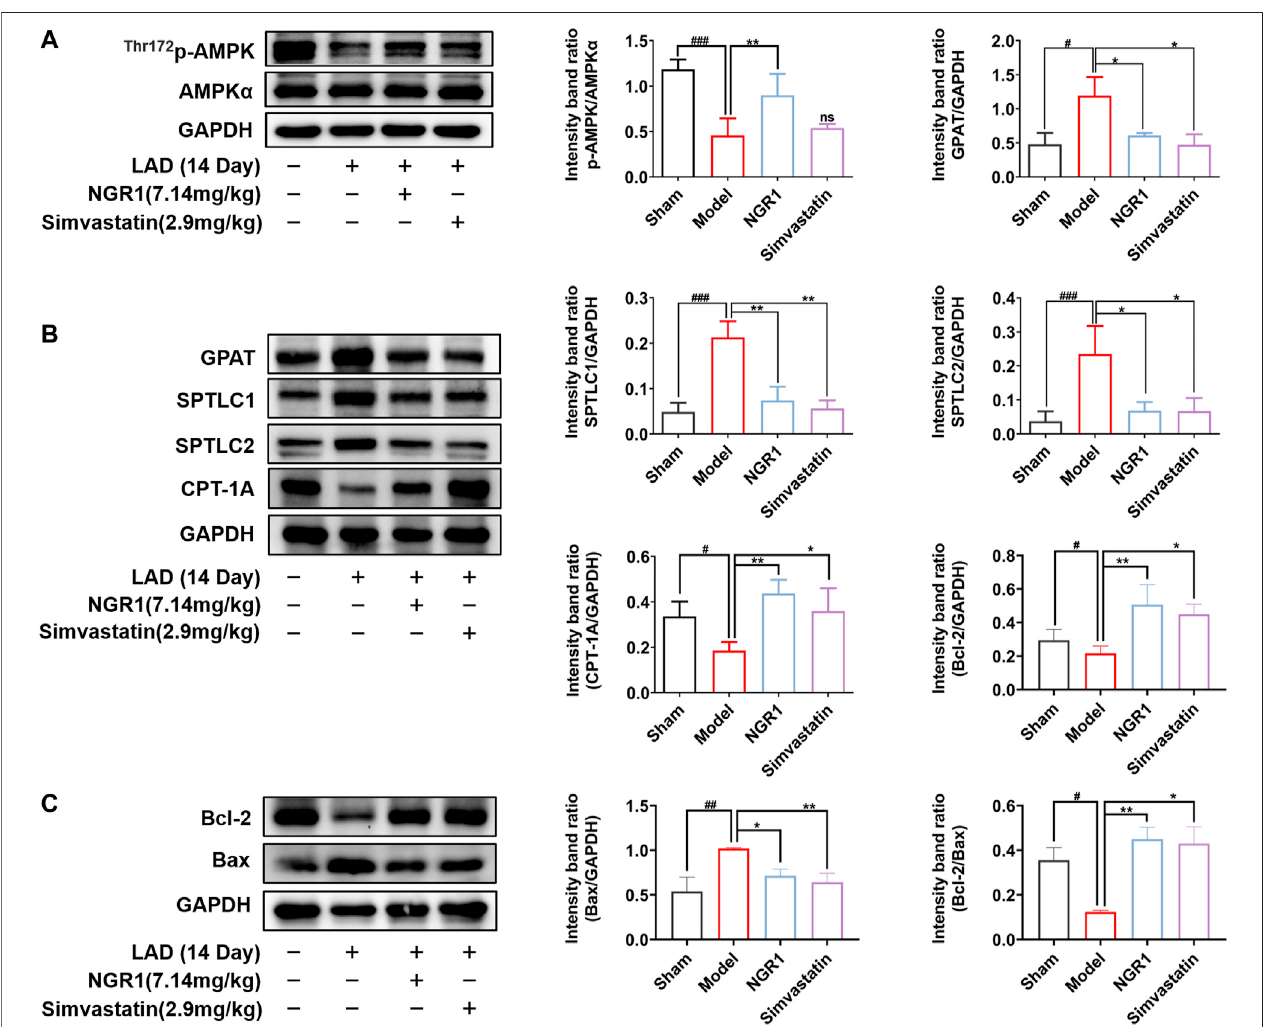
FIGURE 3 | NGR1 regulated lipotoxicity-related proteins and reduced apoptosis in the HF mice model. ( A-C) Western blot analysis of p-AMPK, AMPK, GPAT, SPTLC1, SPTLC2, CPT-1A, Bcl-2 and Bax in each group of mice. GAPDH served as the internal control, * p < 0.05, ** p < 0.01 vs. model group, # p < 0.05, ## p < 0.01, ### p < 0.001 vs. sham group, ns stands for not statistically signi fi cant, N = 3-5 per group.